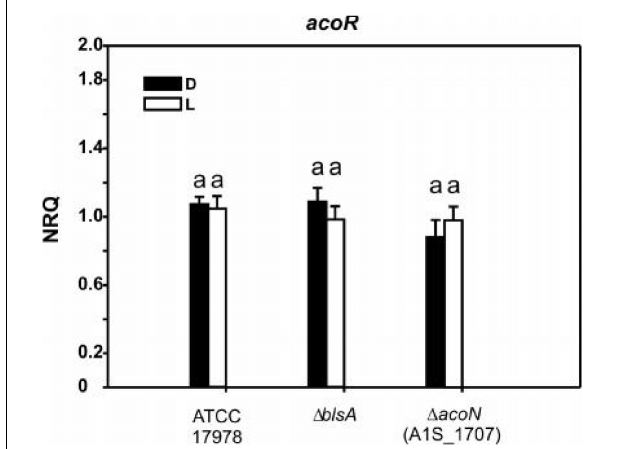
FIGURE 7 | A1S_1697 expression does not depend on light nor on AcoN. Estimation of the expression levels of A1S_1697 by RT-qPCR in A. baumannii ATCC 17978 wild-type as well as (cid:49) blsA and (cid:49) acoN genetic backgrounds at 23 ◦ C under blue light (L) or in the dark (D). The data shown are mean ± SD of NRQs calculated from transcript levels measured in samples grown in M9 minimal media supplemented with acetoin as sole carbon source under blue light or in the dark at 23 ◦ C, in at least three biological replicates. Different letters indicate significant differences as determined by ANOVA followed by Tukey’s multiple comparison test ( p <